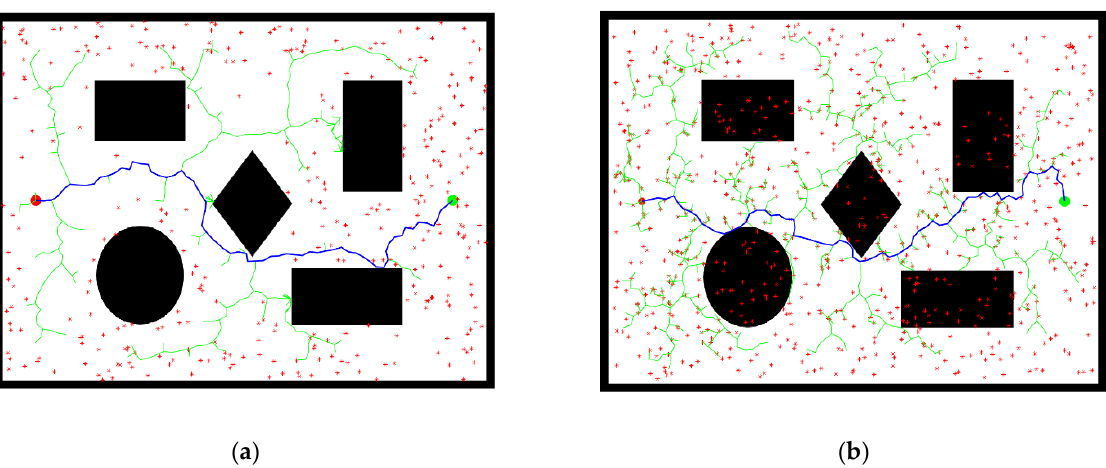
Figure 11. Comparison of the operation results of ( a ) the improved RRT algorithm and ( b ) the RRT algorithm. The sampling points of the Improved RRT algorithm are more densely distributed in the area where the random tree has not reached, and its random tree is more efficient to achieve the state space. As for the RRT, the sampling points are evenly distributed throughout the space. Compared with Improved RRT, it uses more nodes to achieve coverage of the state space.